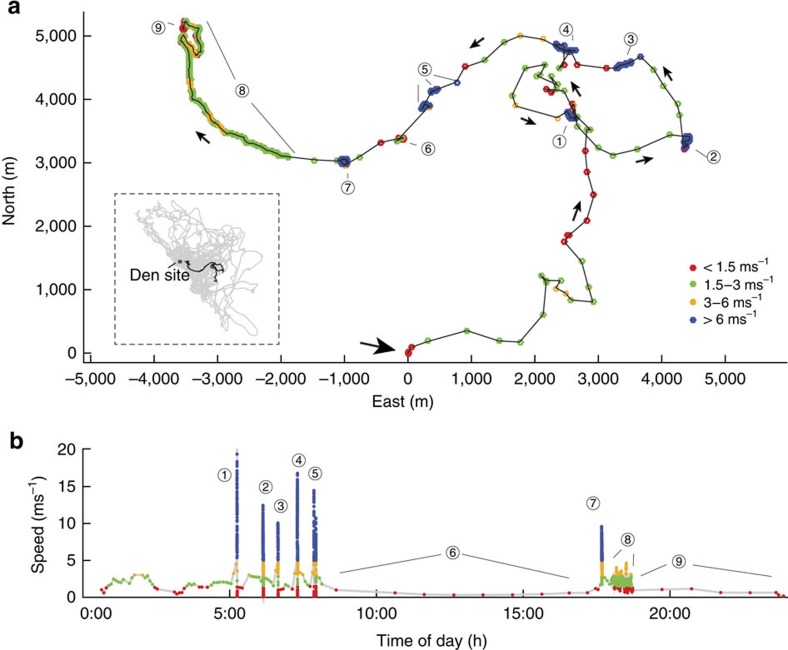
Example day's speed and track for an African wild dog.(a) GPS data trace for one individual, dog position at the beginning of the day (0/0), GPS position colour coded based on speed bins, black arrow shows the direction of the movement, inset shows range covered by dogs during 5 months of observation and trace of example day. (b) Speed profile at local time for one individual colour coded based on speed bins (legend in a). (a,b) Movement is interspersed by six fast chases (circles 1–5 and 7). The GPS sample rate varies throughout the day and is set to capture high-resolution data when the animal is moving. When the animal is stationary, the sampling interval is once an hour (circles 6 and 9). Between 18:00 and 20:00, it is at 10-s intervals (when moving, circle 8), when high-speed chases are detected, it is increased to 5 Hz (circles 1–5 and 7). At all other times, it is once every 5 min when moving.